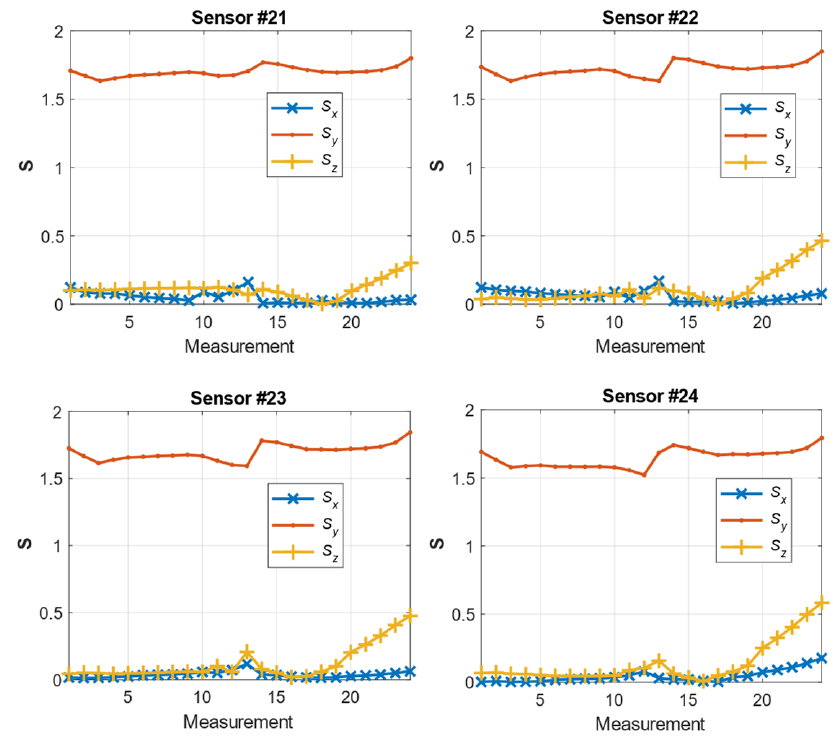
Figure 12. Estimates of the S coefficients for successive stress states for sensors 21–24.